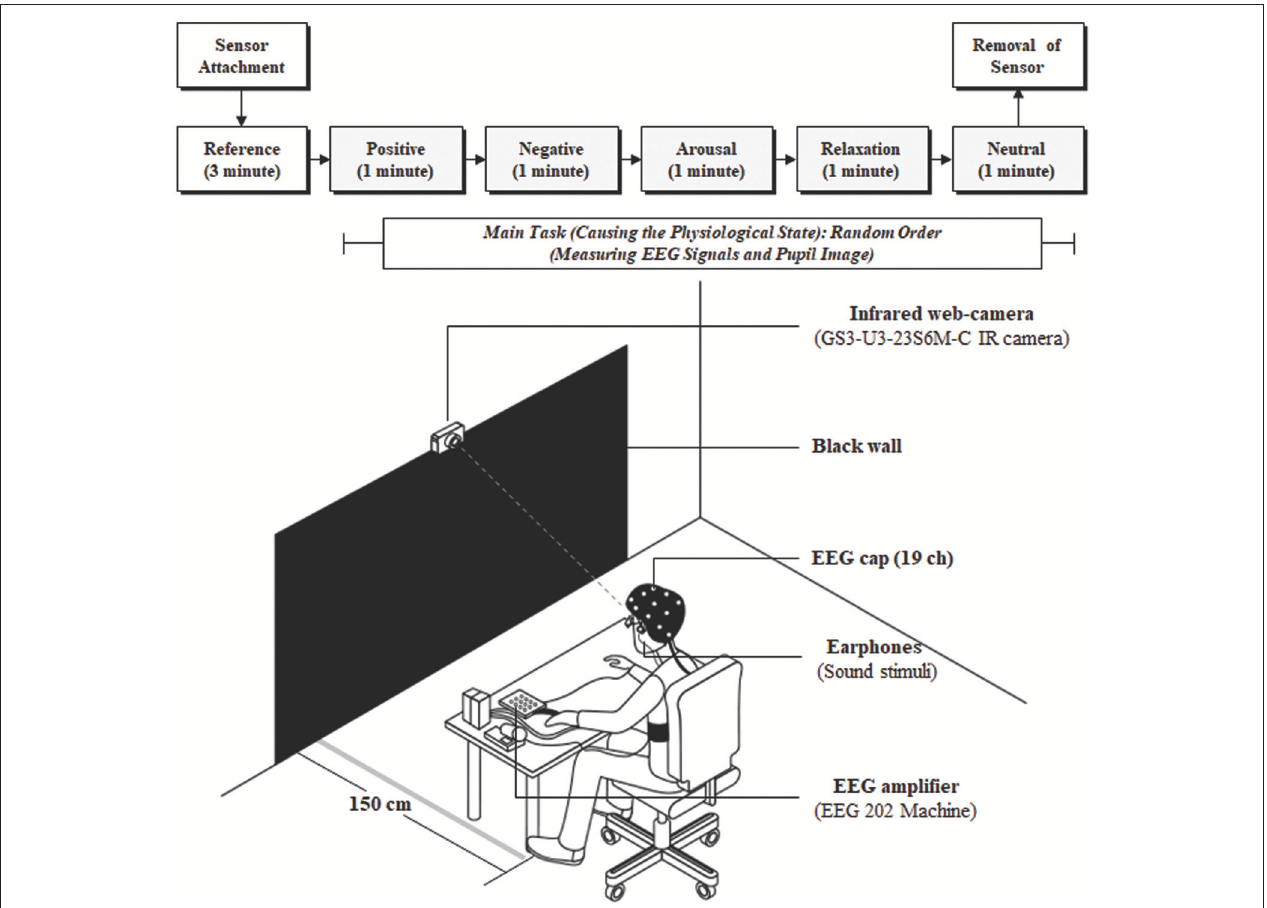
FIGURE 1 | Experimental protocol and configuration. EEG, electroencephalogram; IR,